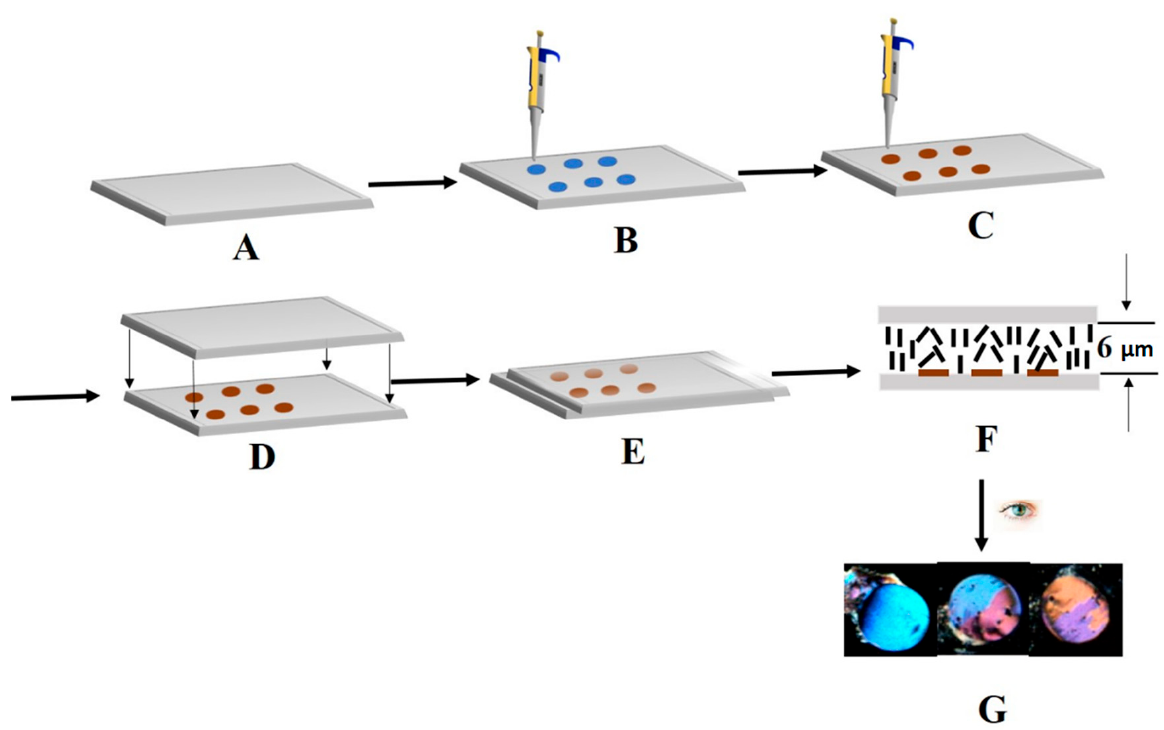
Figure 1. Schematic illustration of the preparation and sensing strategy of proposed bio-sensing approach: ( A ) cleaning and preparation of N,N -dimethyl-n-octadecyl-3aminopropyltrimethoxy-silyl chloride (DMOAP)-coated glass slides; ( B ) dispensing droplets of B40t77 aptamer solution in an array form; ( C ) after immobilization of B40t77 aptamer, gp-120 protein droplets were dispensed on immobilized B40t77 aptamer; ( D ) after washing and drying, place spacer (6µm) on left and right edges of slides, followed by covering the slide with another DMOAP–coated glass slide; ( E ) clip the left and right edges of both slides with clippers to make an optical cell; ( F ) introduce liquid crystal (LC) 4-cyano-4-pentylbiphenyl (5CB) into the prepared optical cell; ( G ) visualization under polarized optical microscope with the naked eye, analysis of final results (dark to bright transition in optical appearances).